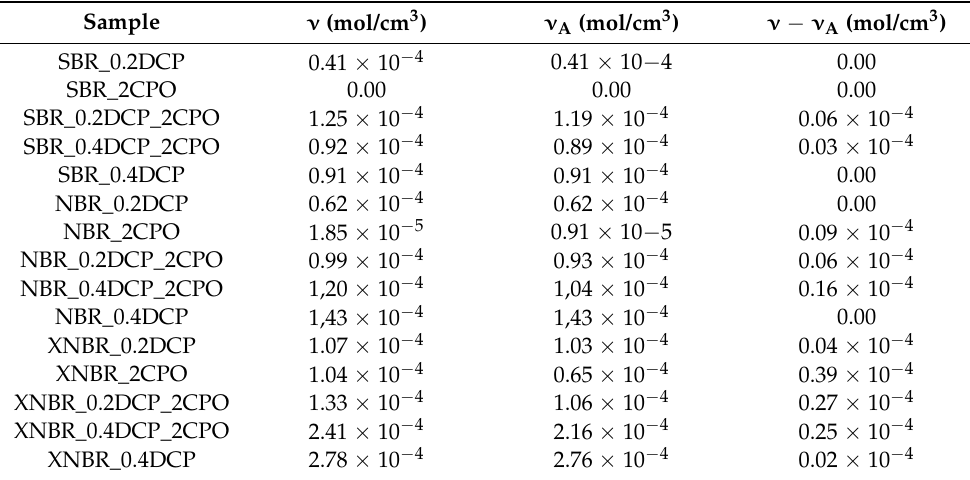
Table 3. Crosslink density and structure of the vulcanizates